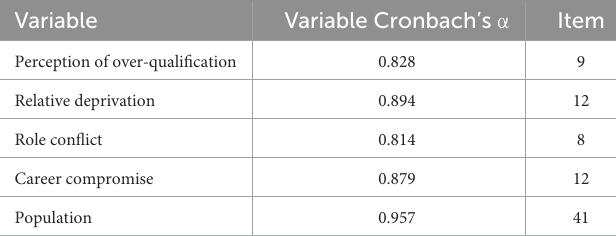
TABLE 2 Reliability analysis of variables.